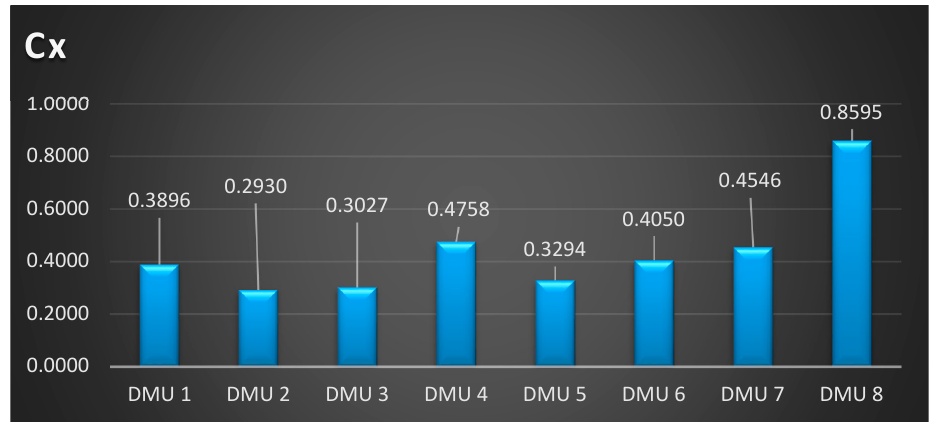
Figure 9. Final performance in technique for order of preference by similarity to ideal solution (TOPSIS) model.